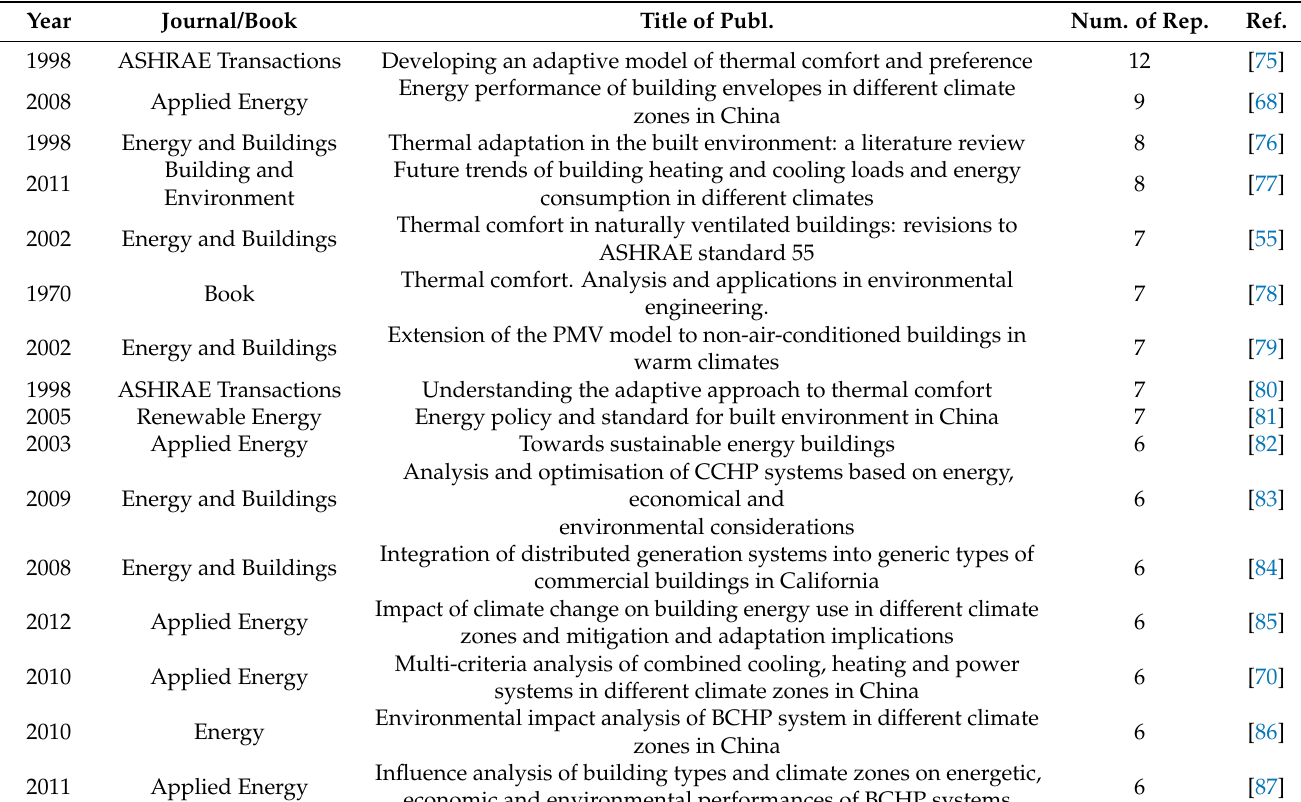
Table 3. Most used articles in the references of analysed